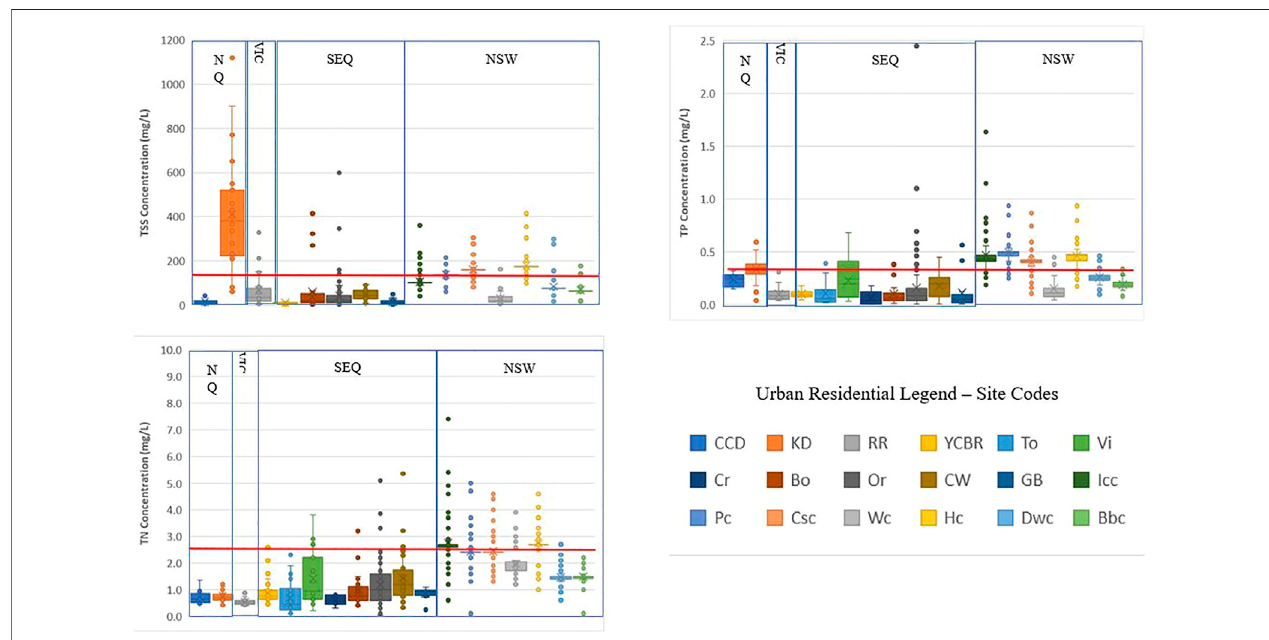
FIGURE 3 | Summary urban residential landuse TSS, TP and TN concentrations for each site by geographic region, with typical values shown in red (WbD, 2018).